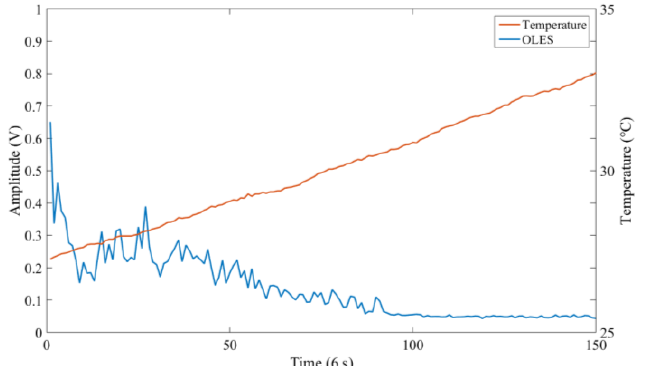
Figure 15. The relation between the electrostatic signal and temperature.